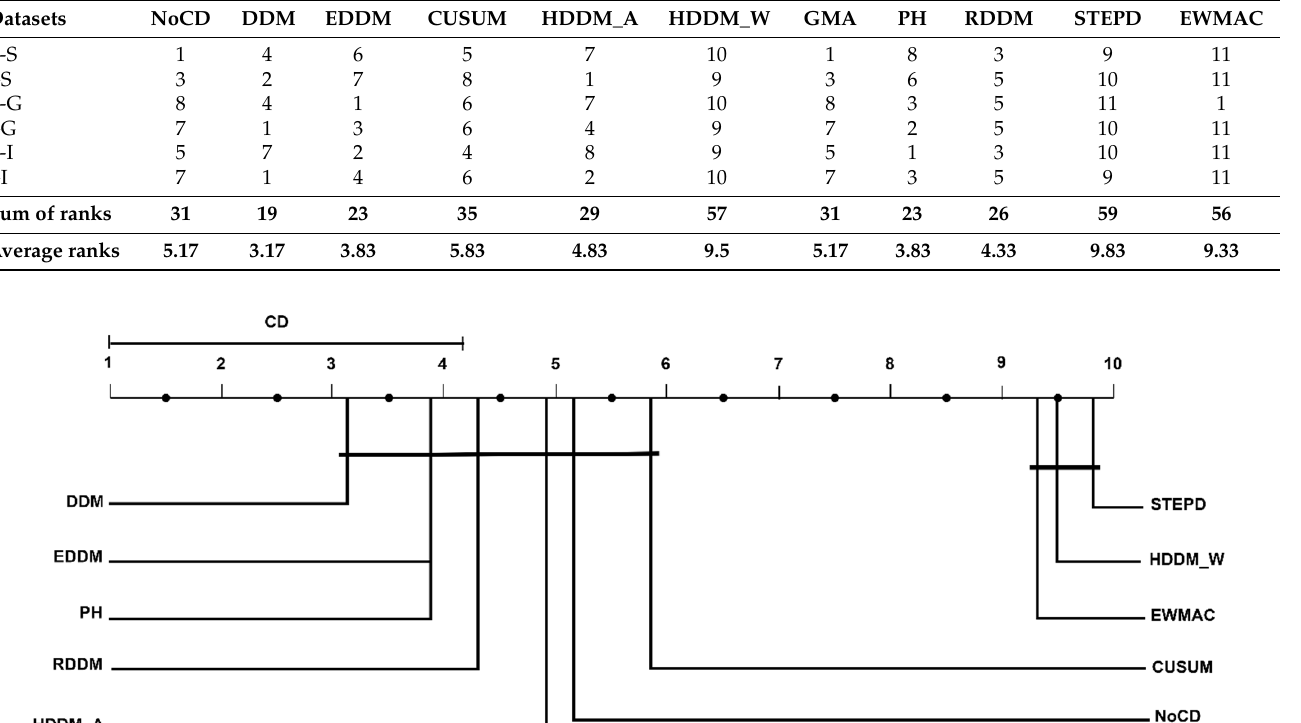
Figure 12. Comparison of drift detection methods against each other with the Bonferroni–Dunn test.